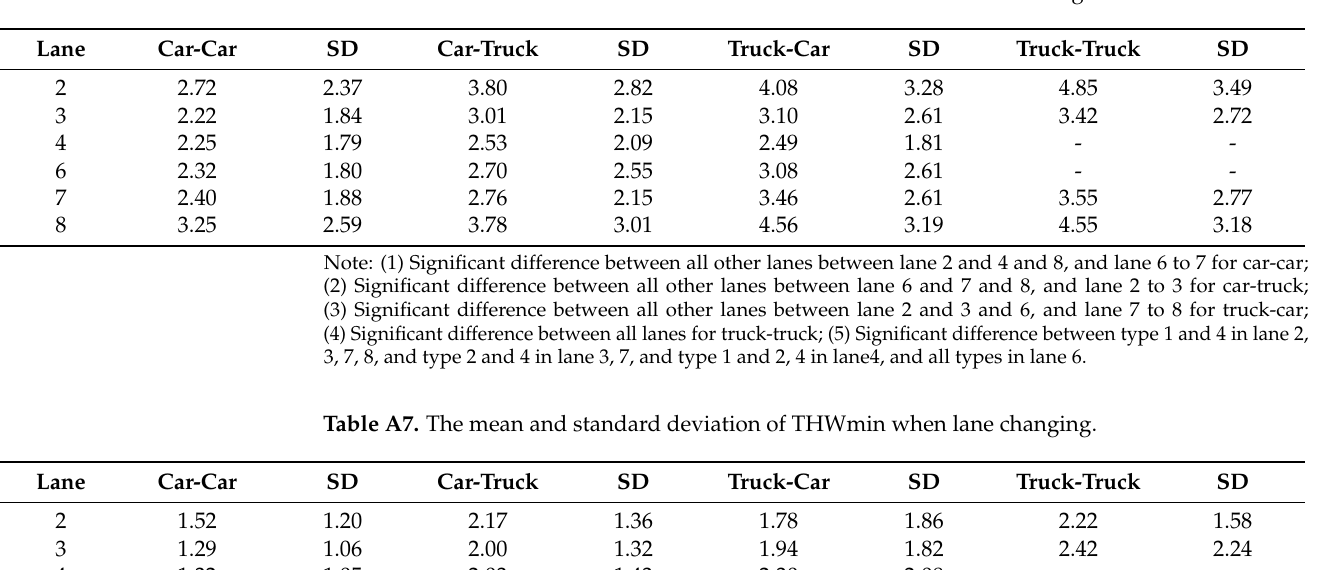
Table A6. The mean and standard deviation of THWmin when car following.